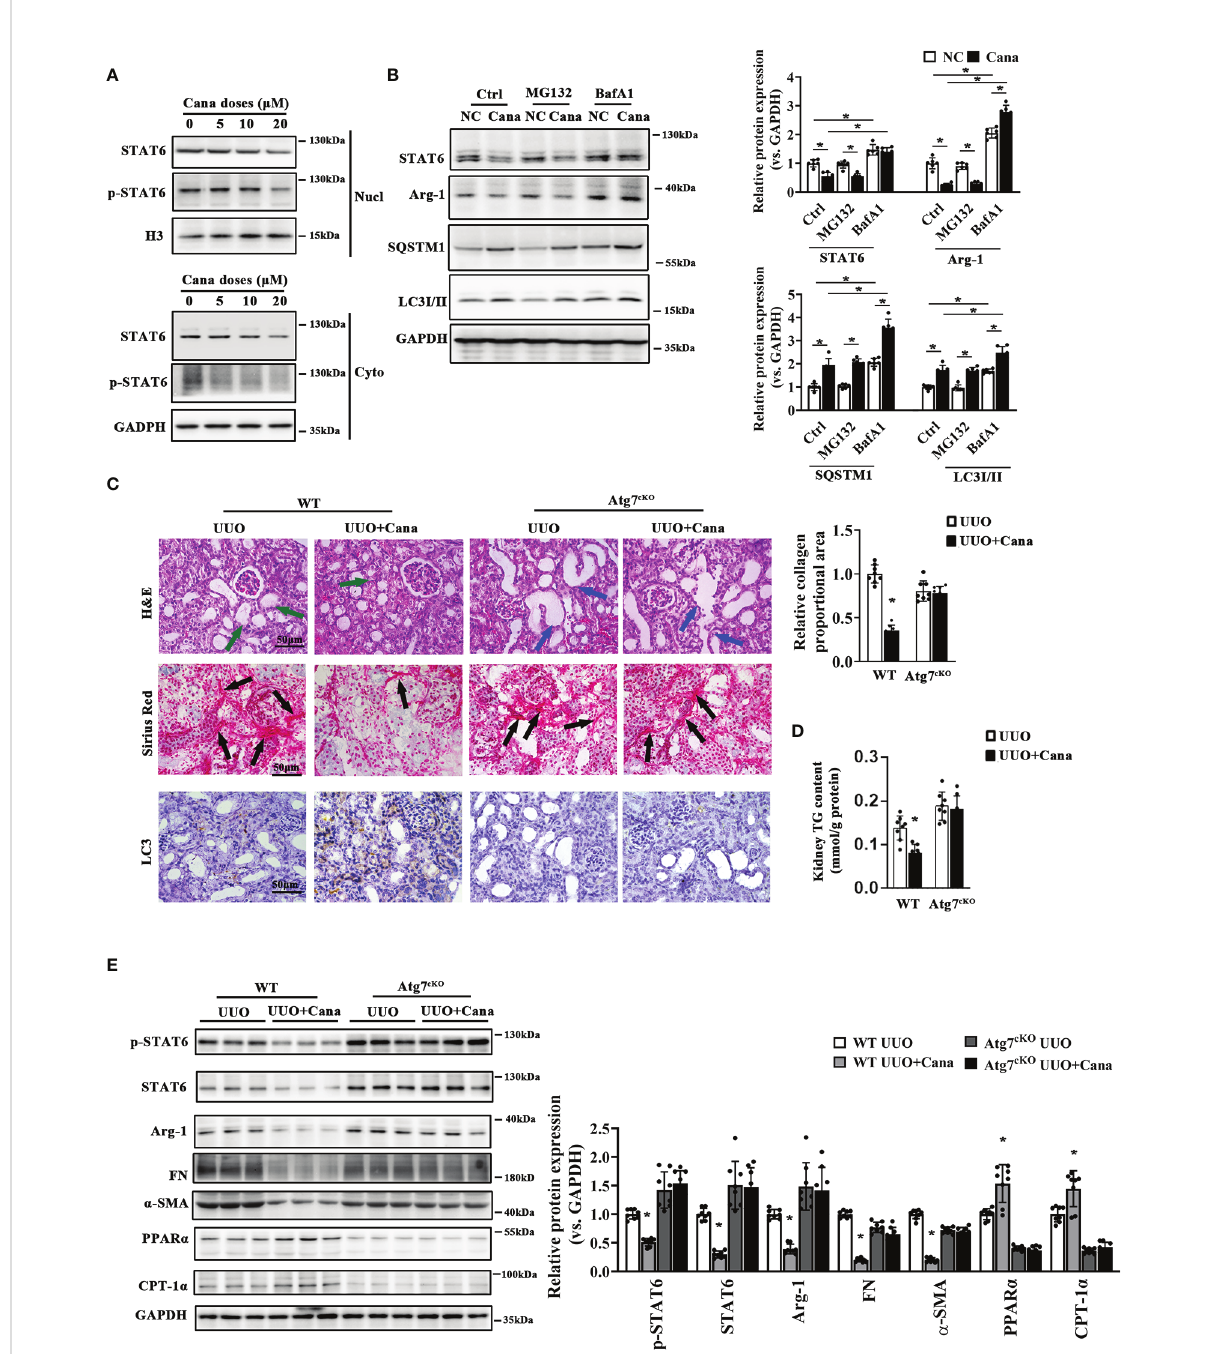
FIGURE 4 Atg7 de fi ciency vanished the protection of Cana in tubulointerstitial fi brosis. (A) HK2 cells were treated with Cana (0 – 20 m M) for 24 h. The protein expression of STAT6 and p-STAT6 in nucleus and cytoplasm was separated and determined by immunoblot analyses. (B) HK2 cells were pretreated with MG132 (10 m M) or BafA1 (100 nM) for 4 h and cotreated with or without Cana after being cultured with serum-free medium for 24 h. The cell lysates were subjected to immunoblot analyses with the indicated antibodies. (C – E) WT and Atg7 cKO mice received intragastric administration of saline or Cana (20 mg/kg) after UUO operation. (C) Representative images of H&E, Sirius Red, and IHC staining of kidney sections from the indicated group of mice. Quanti fi cation of the relative collagen proportional area from each group of mice was performed. (D) TG content in kidney tissue was measured by a commercial kit. (E) Immunoblot analyses for the protein levels of p-STAT6, STAT6, Arg-1, FN, a -SMA, PPAR a , CPT-1 a , and GAPDH in kidney from the indicated group with quanti fi cation on the right panel (n = 8, * p < 0.05, UUO vs . UUO +